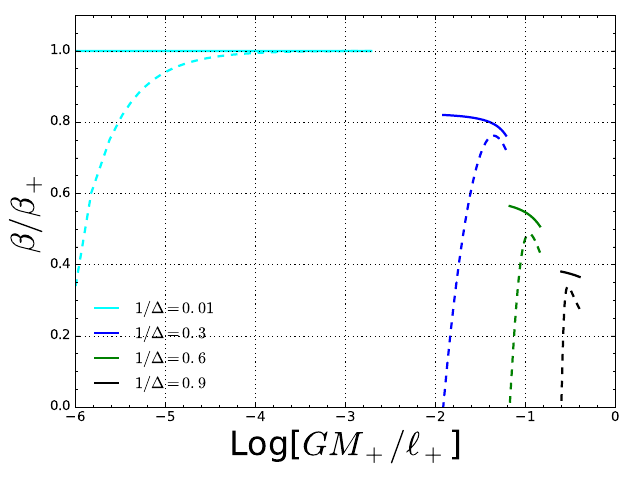
Figure 7 . Ratio β in /β + (continuous lines), where β in is the temperature inside the shell, and β − /β + (dashed lines), where β − is the temperature of the inside black hole horizon, as a function of the initial black hole mass. We plotted it for ℓ + = 3 ℓ − and we let ∆, i.e. 4 πGσℓ + , vary. Notice that the lines never intersect, therefore β in = β − in general. For the light blue line, i.e. ∆ = 100, 6 one check that β in β − > 10 − 5 β + . Obviously, β − = 0 when M − = −